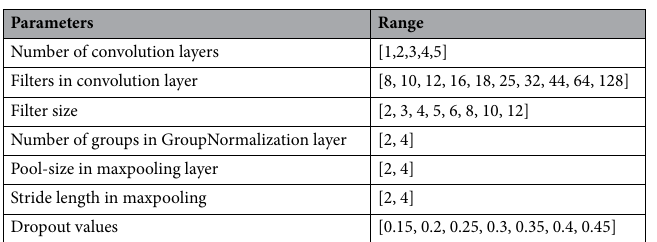
Table 2. Demonstration of hyper-parameter tuning of proposed